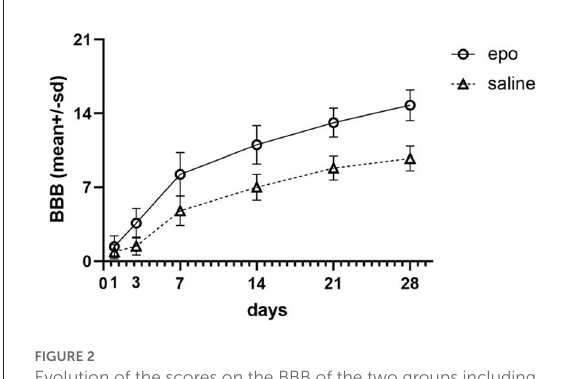
FIGURE2 Evolution of the scores on the BBB of the two groups including the six (1, 3, 7, 14, 21, and 28 days) evolution periods. BBB, Basso-Beattie-Bresnahan locomotor rating.